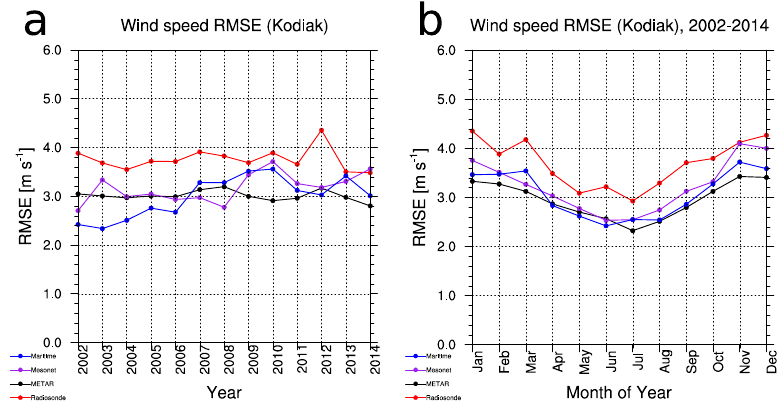
Figure 16. As in Figure 10, but for root mean squared error over the Kodiak region only.